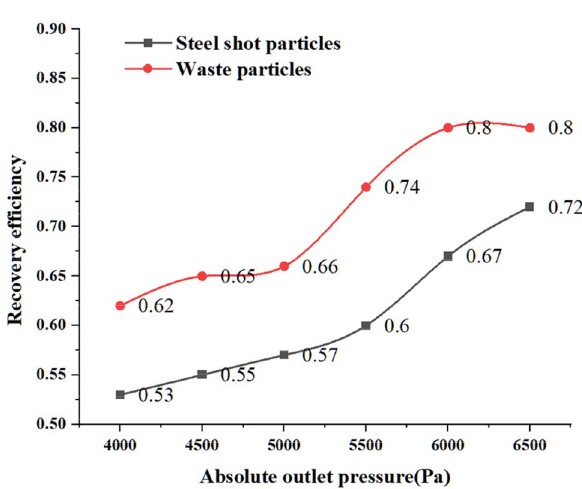
Figure 13. Number of particles in each position at different pressures ( a ) steel shot particles ( b ) waste particles.